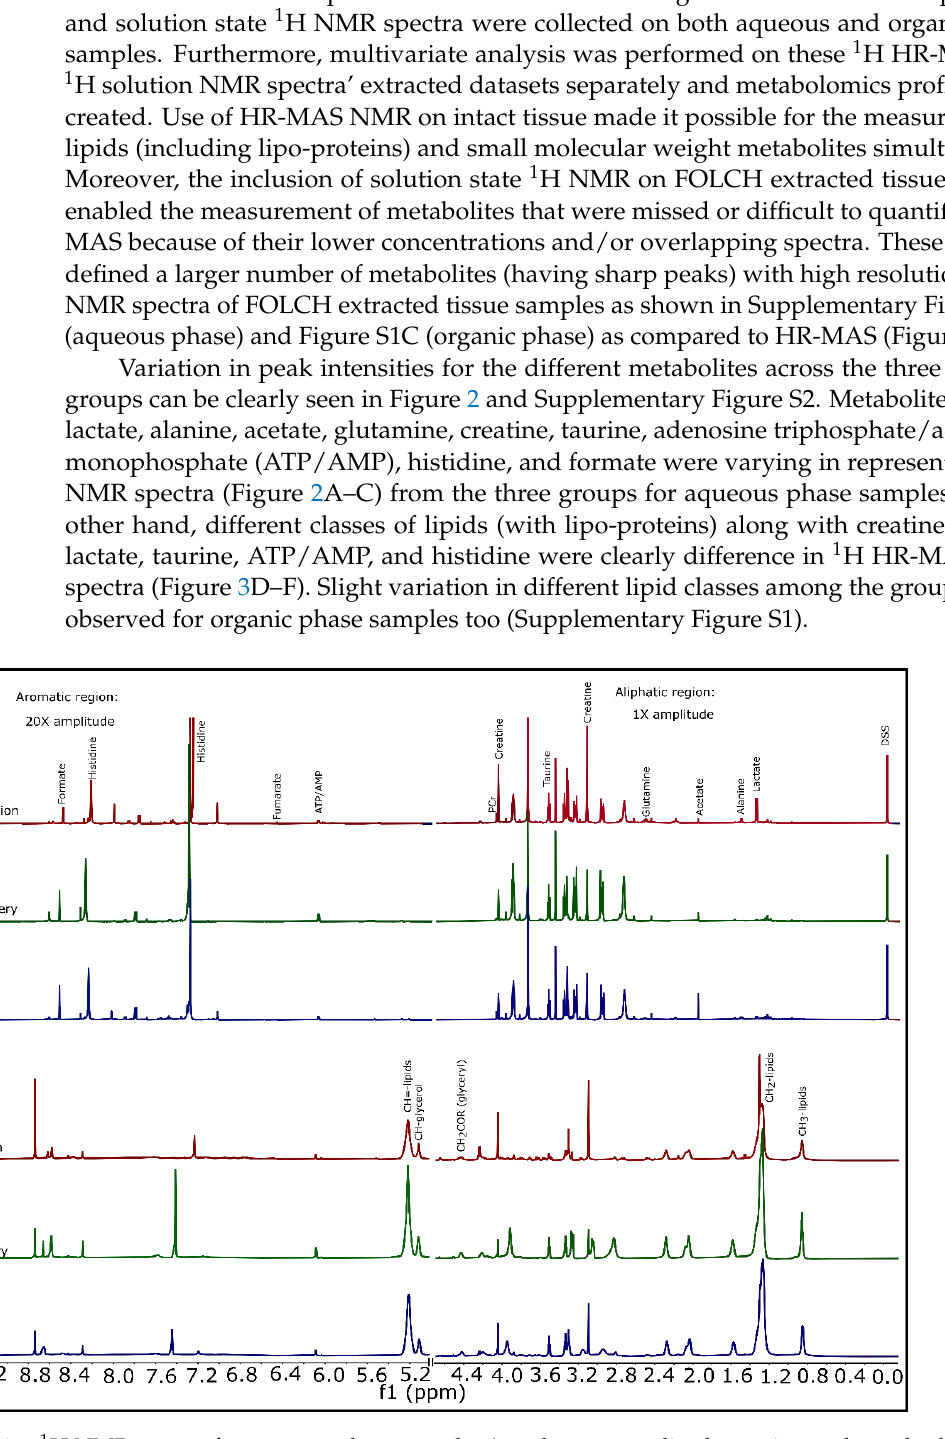
Figure 2. Representative 1 H NMR spectra for aqueous phase samples (top three; normalized w.r.t. internal standard DSS peak at 0.0 ppm) and 1 H HR-MAS (bottom three; without normalization) for gastrocnemius tissues for all three groups: control, CLTI Pre-surgery, and CLTI Amputation. Selected labeled metabolites/compounds that are significantly different between three groups are assigned for convenience.